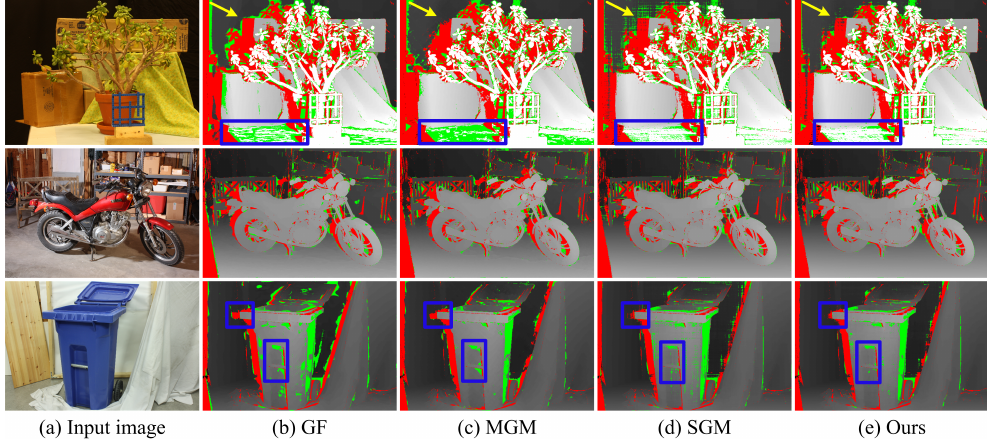
Figure 7. Disparity images of various methods on Middlebury 2014 dataset [36]. Pixels in red and green are mismatched pixels in occluded and non-occluded regions